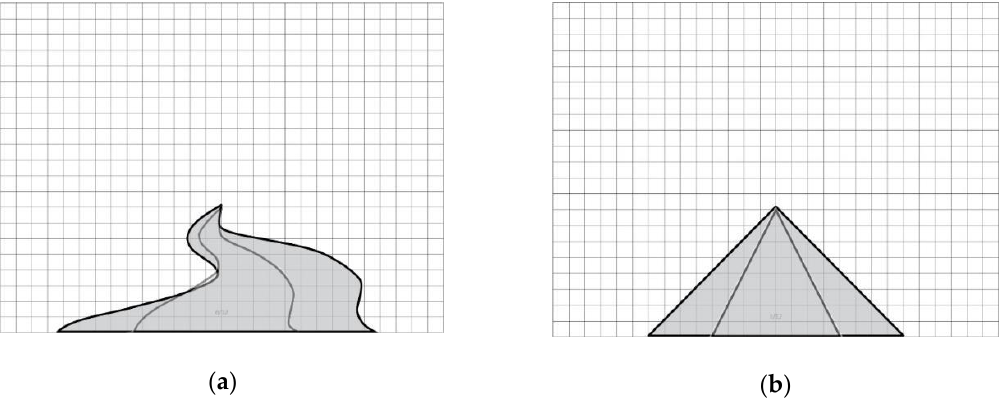
Figure 11. Taking the simplest path mode as an example: ( a ) path mode curve; ( b ) path mode line.